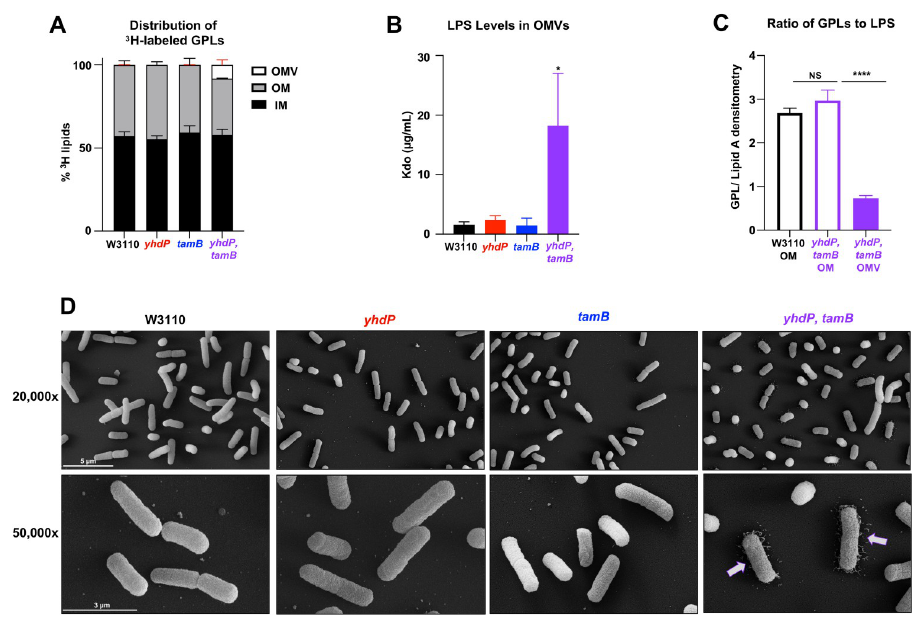
Fig 5. yhdP , tamB mutants shed OMVs that are rich in LPS. (A) 3 H-labeled membrane separation. Listed strains were grown to mid-log phase in the presence of 3 H-glycerol to label GPLs. Inner and outer membrane fractions were separated by a 3-step sucrose gradient and OMVs were collected separately (error bars in red). IM peak fractions are indicated by NADH oxidase and OM peak fractions are indicated by LPS levels ( S2 Fig ). The % of 3 H-incorporation to indicate GPL levels were performed in biological triplicate. (B) Kdo levels measured from collected OMVs. Growth supernatants were collected, filtered, and OMVs collected by centrifugation. Purpald reagent was used to determine Kdo levels. Error bars represent SD from technical triplicate and is representative of two biological experiments. (C) Total lipid levels of 32 P i labeled OM and OMV content. WT and yhdP , tamB cells were grown to mid-log phase and the OM fraction and OMVs were collected and total lipids were extracted for TLC analysis ( S3 Fig ). Error bars represent SD from biological triplicates. 0.001 > P ��� , 0.0001 > P ���� , NS = not significant. (D) Scanning electron microscopy (SEM) of yhdP , tamB mutants. Top row 20,000x zoom. Bottom row 50,000x zoom. White scale bar set to 5 or 3 μ